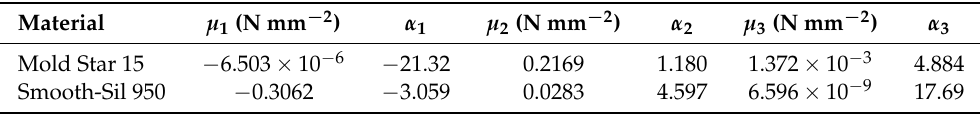
Table 1. Ogden parameters for Mold Star 15 and Smooth-Sil 950 derived from materials testing in accordance with ISO 37:2011 and ISO 7743.